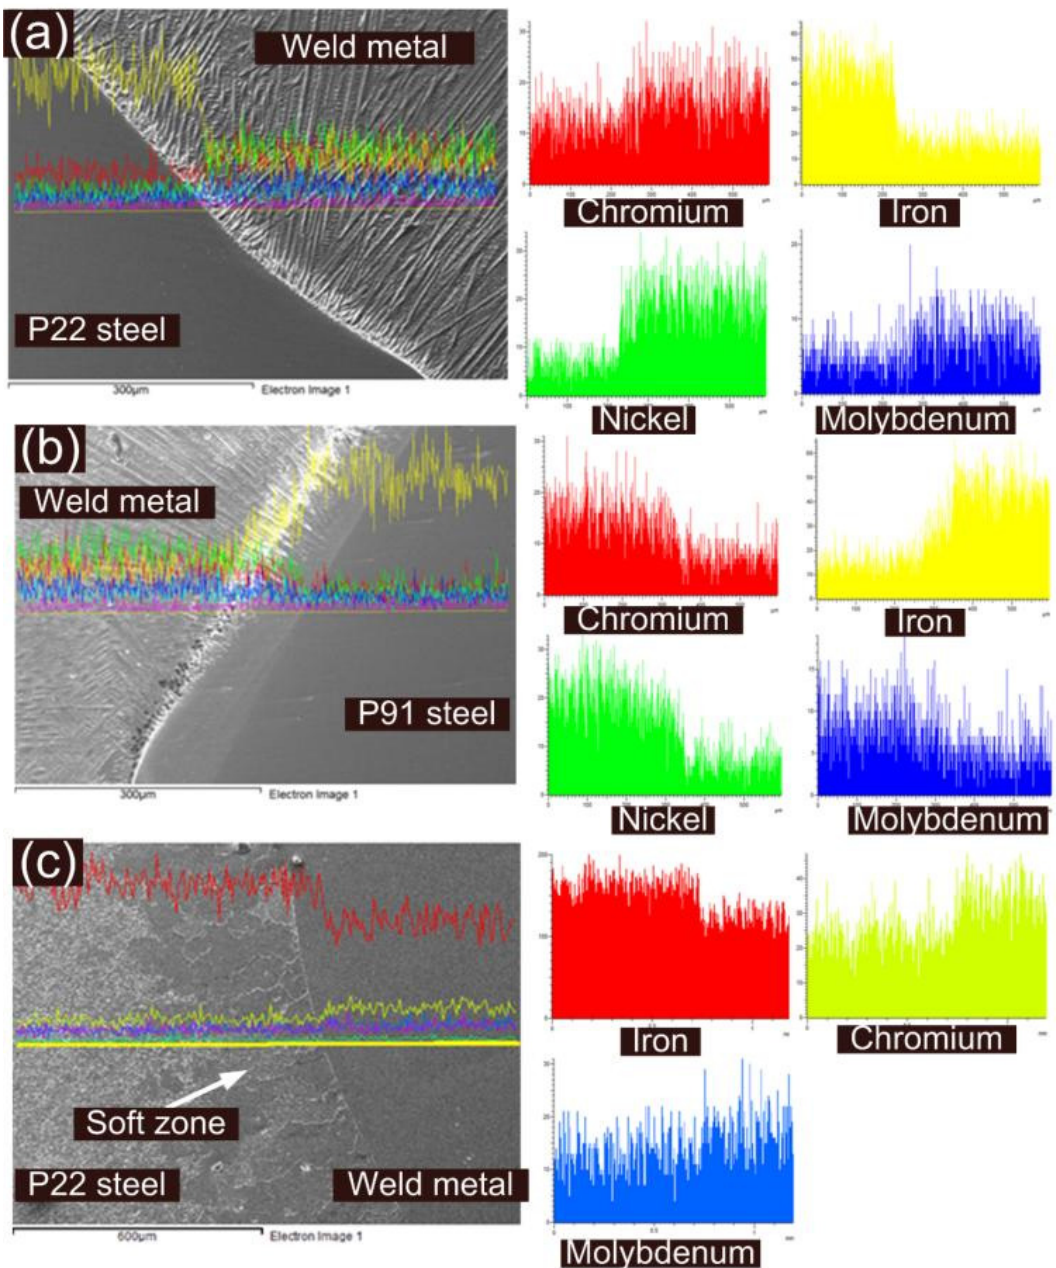
Figure 11. Elemental profile at the interface of ( a ) P22 steel and ERNiCrMo-3 weld metal, ( b ) P91 steel and ERNiCrMo-3 weld metal for AW joint; ( c ) P22 steel and ERNiCrMo-3 weld metal after the PWHT.